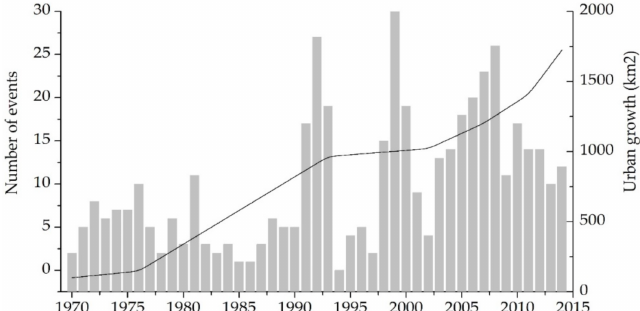
Figure 2. Number of flood events reported in Veracruz (light gray bar) between 1970 and 2015. Urban area (solid black line) for the same period. Source: CENAPRED (1989–2019), FONDEN (2000–2010), DesInventar (1970–2015) and INEGI (1970–2015).